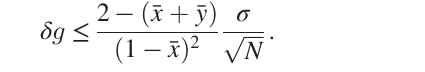
Table VII. The predicted FCI scores from both HFCIs are